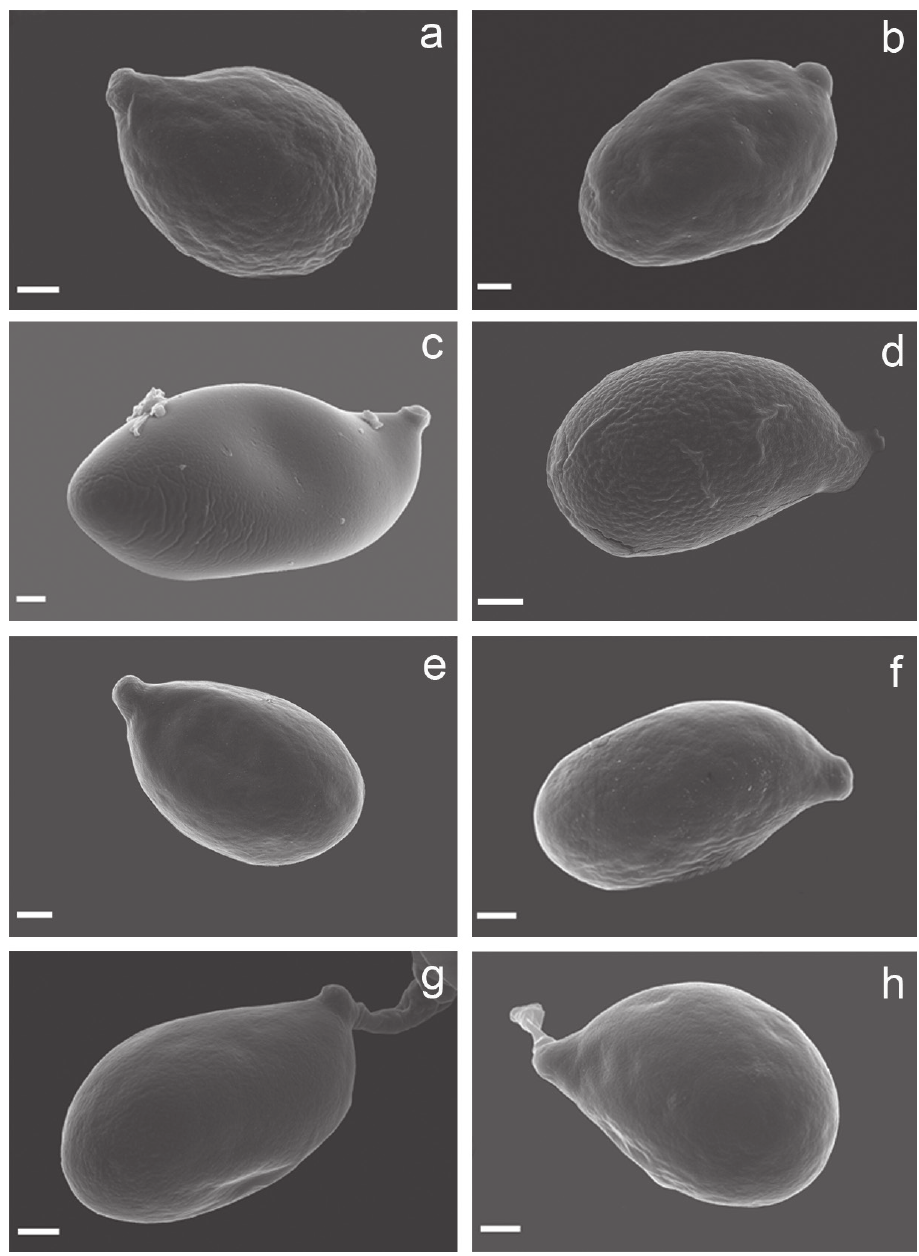
Figure 4. Basidiospores of Clavariadelphus under SEM. a C. alpinus (HKAS 57396, holotype) b C. amplus (HKAS 54876, holotype) c C. elongatus (HKAS 76589) d C. gansuensis ( HKAS 76487, holotype); e, f C. himalayensis (HKAS 58811) g C. khinganensis (MHHNU 7789, holotype) h C. yun- nanensis (HKAS